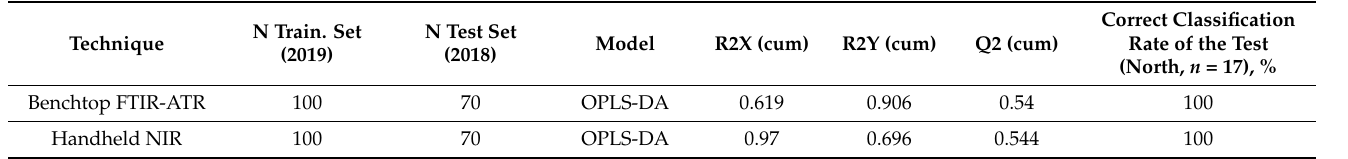
Table 3. Correct classification rate of the samples from the northern region obtained with OPLS-DA model using 2019 full dataset as a training set and 2018 full dataset as a test set.